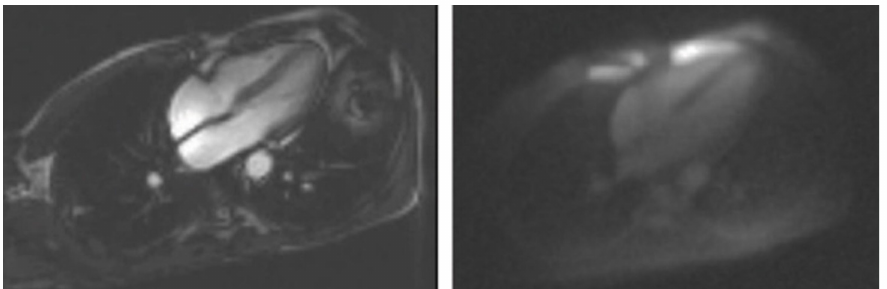
Figure 10. Hydrogen image True-FISP ( left ) and sodium image 2D-UTE ( right ). Reprinted by permission from Robson et al., J Cardio Magn Reson 2008 [31].